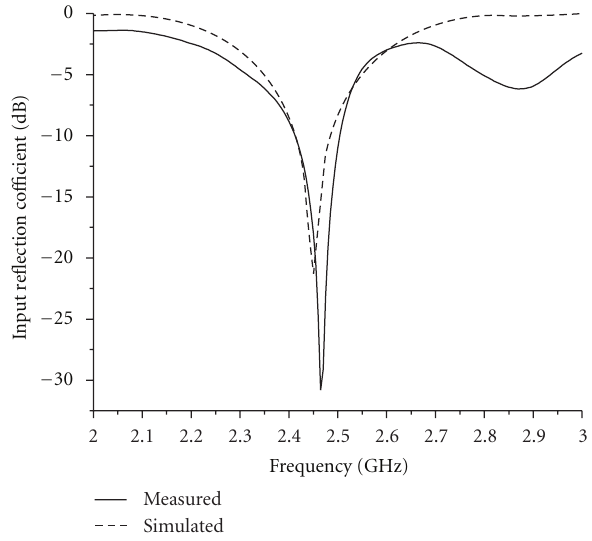
Figure 8: The simulated and measured input reflection coe ffi